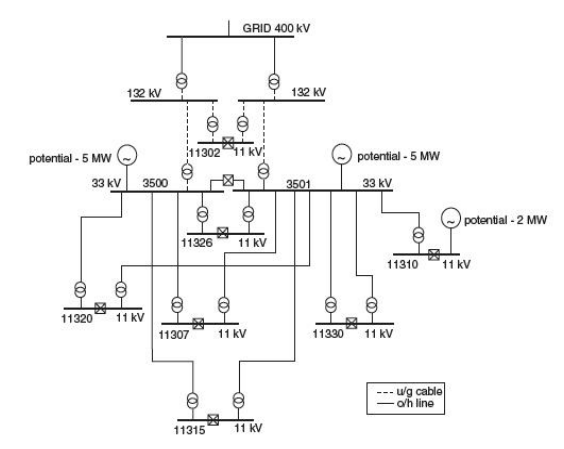
Fig.3. A test distribution